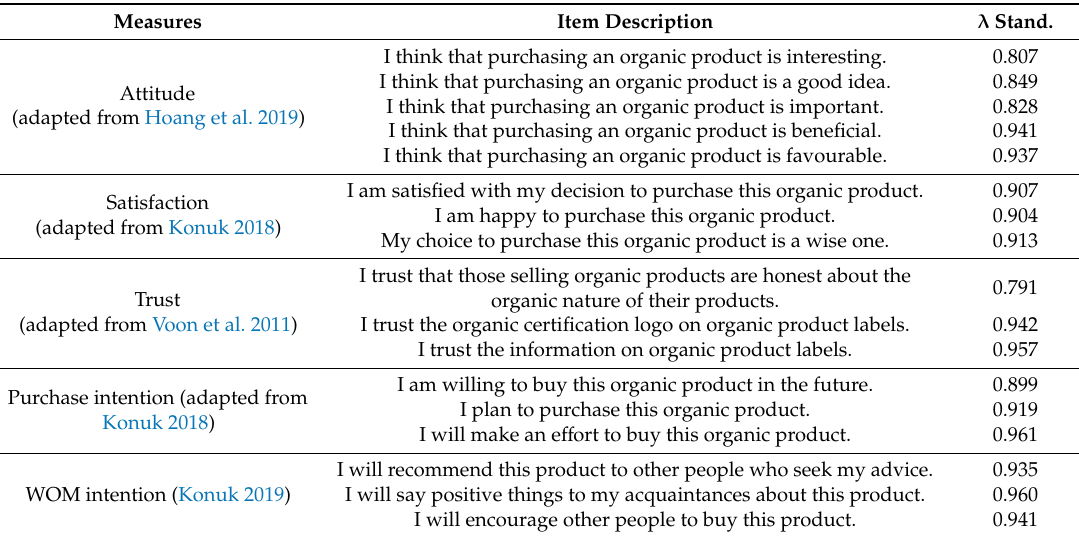
Table 2. Reliability and validity analysis.